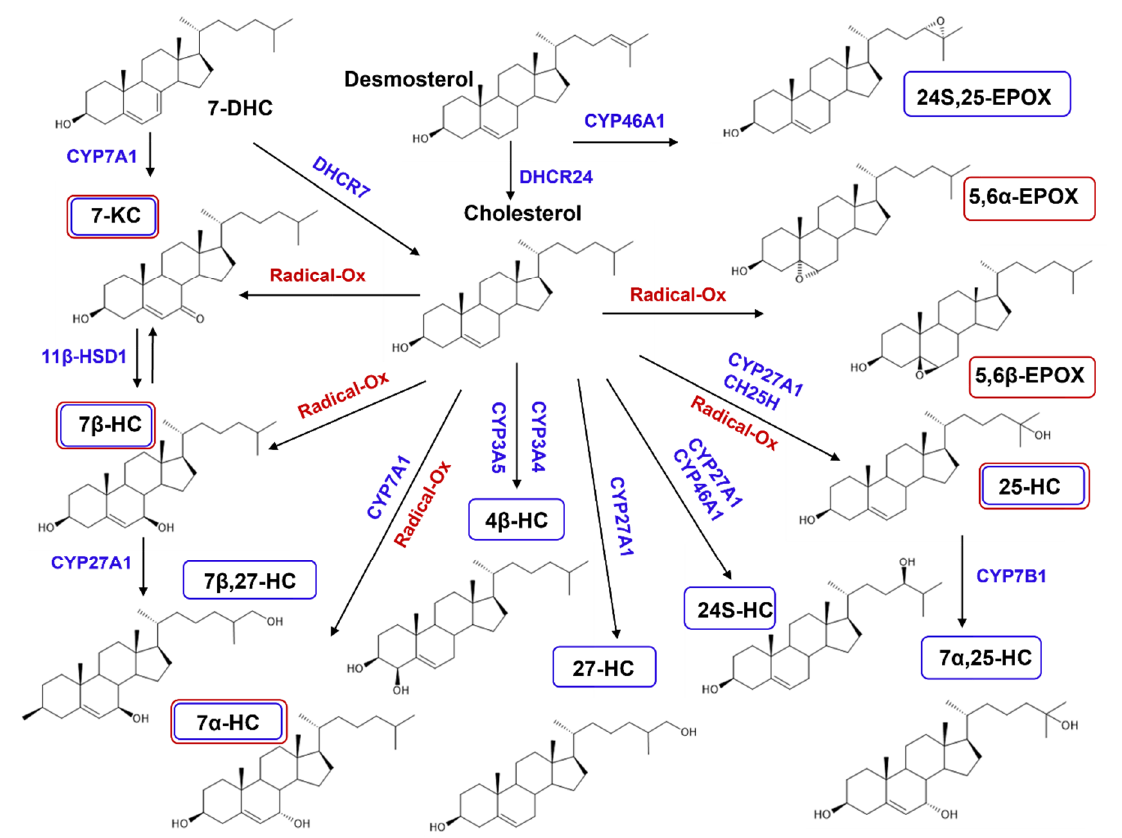
Figure 3. Pathways of cholesterol oxidation. Cholesterol gives rise to oxysterols via enzymatic and non-enzymatic routes. Dietary oxysterols are produced by the oxidation of cholesterol with oxygen and ROS, i.e., non-enzymatic routes. De novo synthesized oxysterols are produced by enzymes belonging to the cytochrome P450 (CYP) family. CH25: cholesterol 25-hydroxylase, EPOX: epoxycholesterol, DHCR: dehydrocholesterol reductase, HC: hydroxycholesterol, HSD: hydroxysteroid dehydrogenase, KC: ketocholesterol, Radical-Ox: radical oxidation.